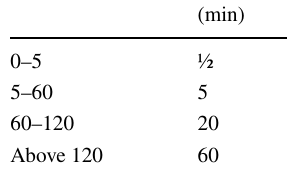
Table 1 Range of interval between water-level measurements in pumping